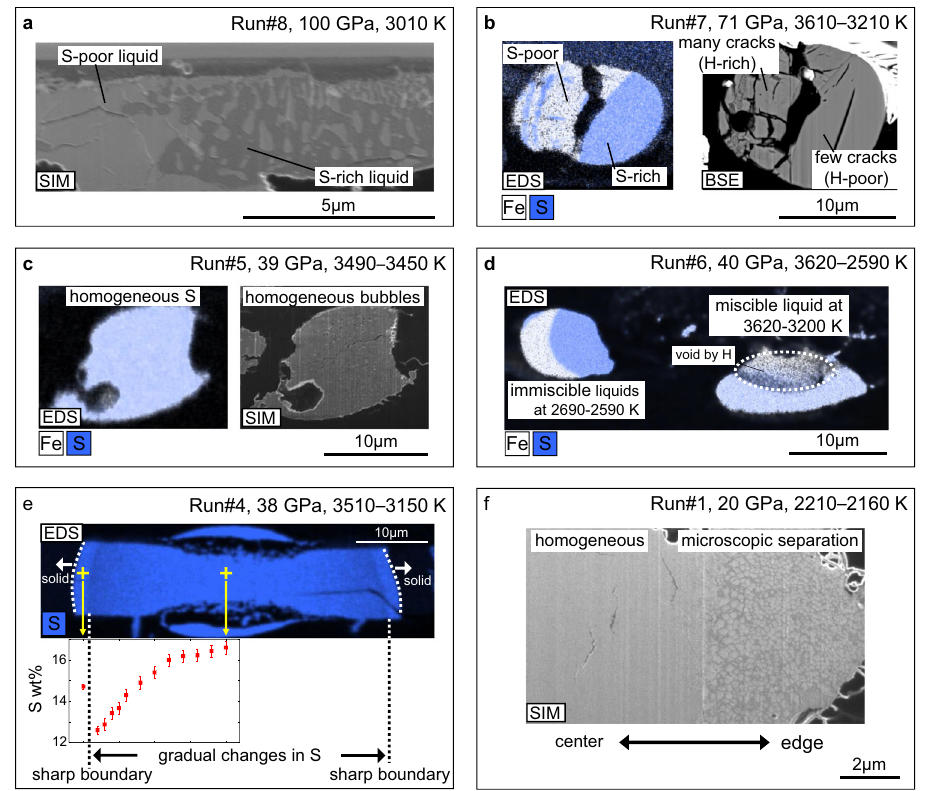
Fig. 1 Textures of two immiscible liquids and a single homogeneous liquid. Scanning ion microscope (SIM) and backscattered electron (BSE) images, and X-ray maps for Fe and S concentrations obtained by energy-dispersive X-ray spectrometry (EDS) for sample cross sections from runs #8 ( a ), #7 ( b ), #5 ( c ), #6 ( d ), #4 ( e ), and #1 ( f ). A sulfur concentration pro fi le is given in e . Dark domains in X-ray maps represent Al 2 O 3 pressure medium or diamond/